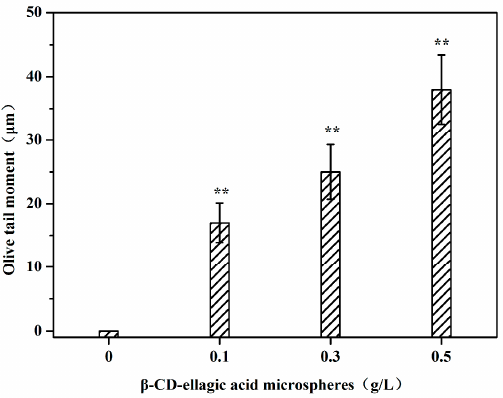
Figure 6. Effects of different concentrations of ellagic acid microspheres on the Olive tail moment of HepG2 cells. Significant differences between the ellagic acid microsphere groups and control group were tested using the Student-Newman-Keuls (S–N–K) test, ** p < 0.01.